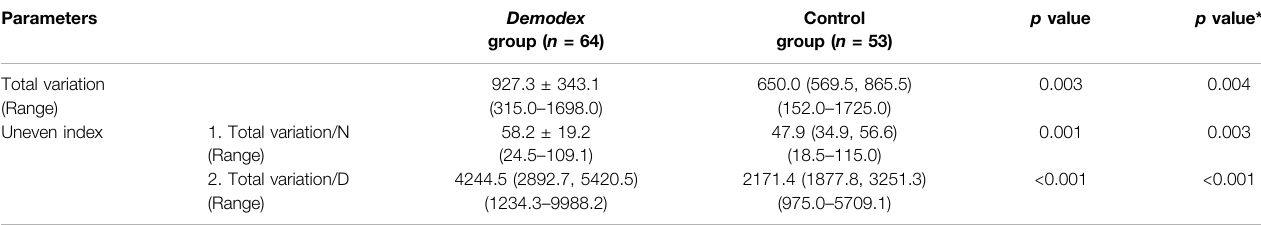
TABLE 4 | Upper lid total variation in Demodex -positive and Demodex -negative patients.